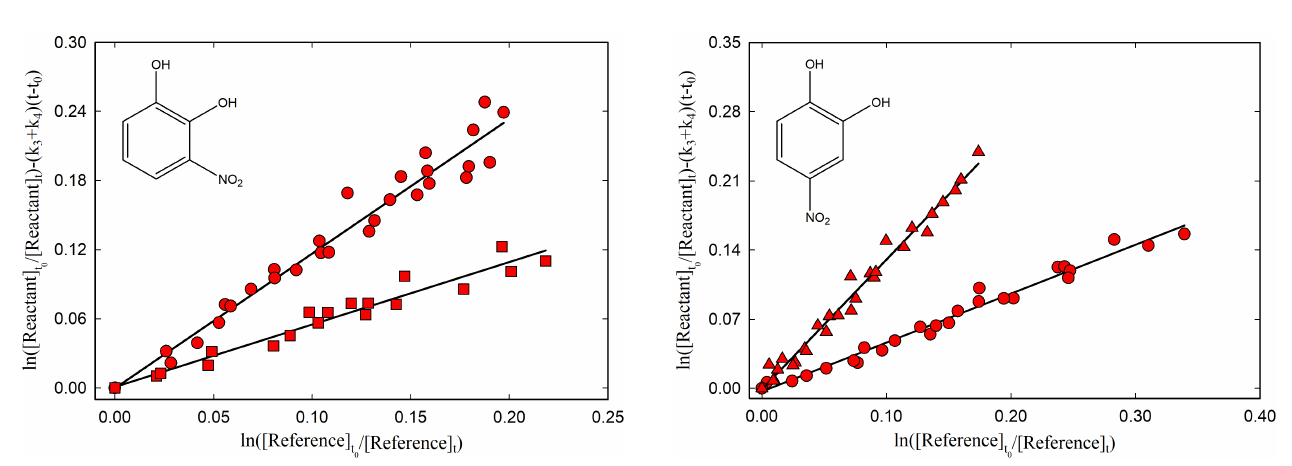
Figure 2. Kinetic plot according to Eq. (1) for the reaction of 4-nitrocatechol with OH radicals relative to dimethyl ether (red circle), using photolysis of CH 3 ONO / NO mixture at 365nm as OH-radical source, and relative to methanol (red triangle), using photolysis of H 2 O 2 at 254nm as OH-radical source, with ( k 3 +